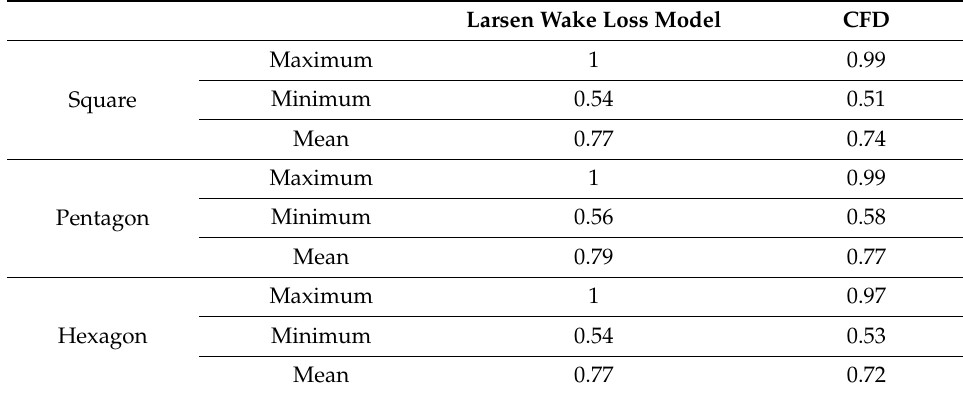
Figure 14. Comparison of the normalized velocity profile at the downstream turbine. Table 3. Comparison of normalized streamwise velocity.